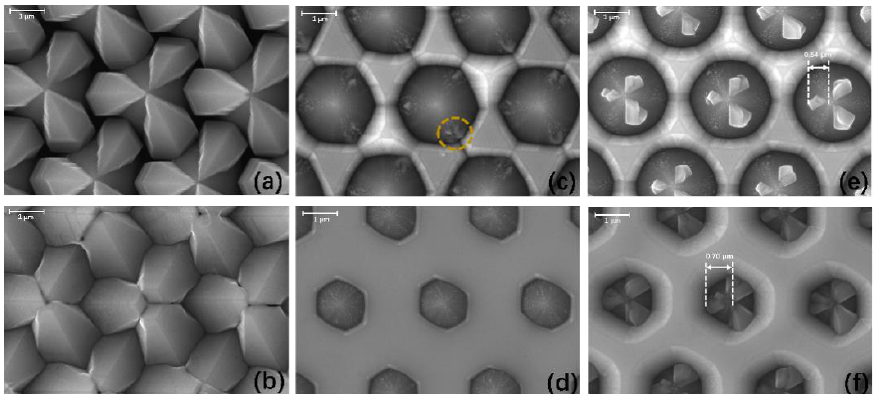
Figure 2. Top-view SEM images of GaN films on ( a ) 10 nm, ( c ) 25 nm, and ( e ) 40 nm sputtered AlON/PSS templates at stage 1; GaN films on ( b ) 10 nm, ( d ) 25 nm, and ( f ) 40 nm sputtered AlON/PSS templates at stage 2.